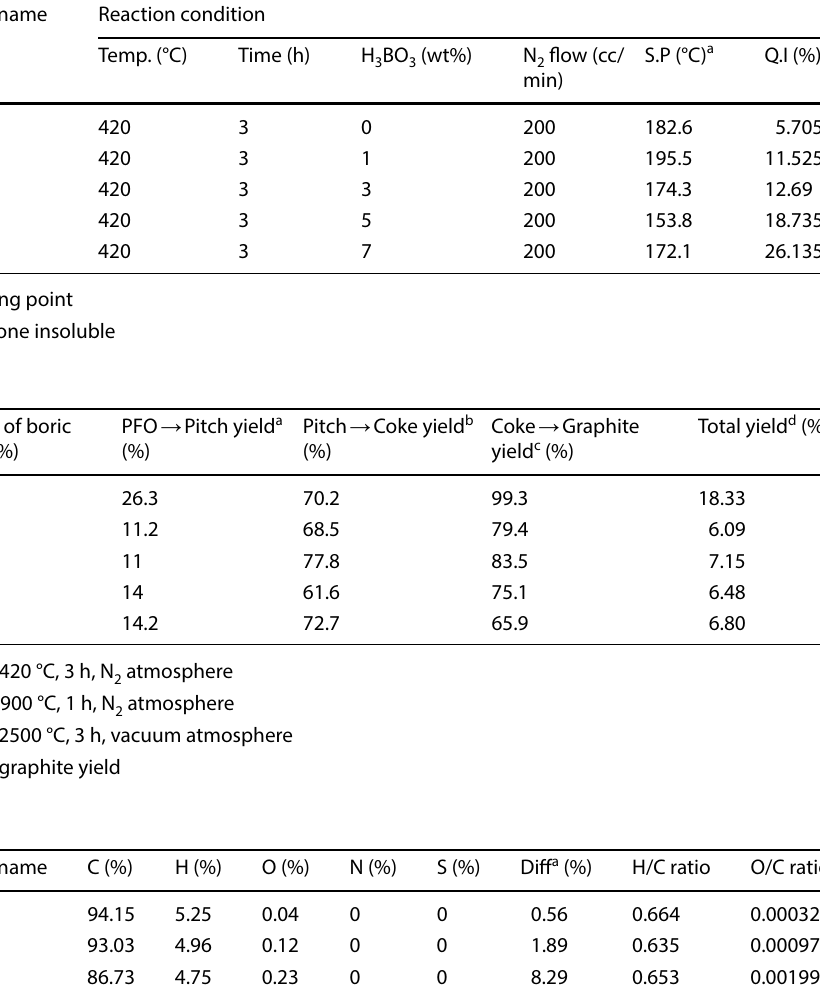
Table 1 Experimental conditions for thermal condensation of PFO